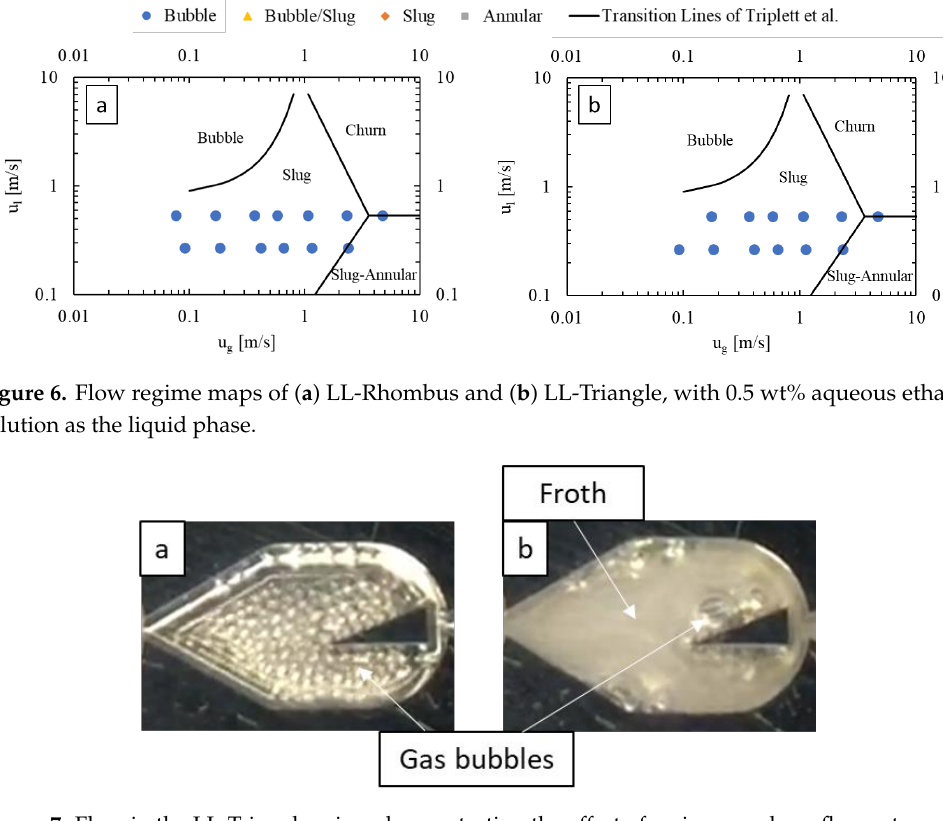
Figure 7. Flow in the LL-Triangle mixer demonstrating the e ff ect of an increased gas flow rate on the flow morphology where surfactant is present. Gas velocities are ( a ) 0.091 m / s and ( b ) 0.65 m / s, and the liquid velocity is 0.27 m / s. Note that ( a ) demonstrates bubble flow, and ( b ) demonstrates bubble flow with froth